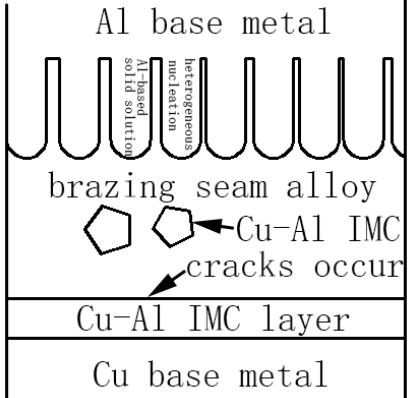
Figure 10. Schematic diagram of microstructure in the Cu/Al brazed joint.